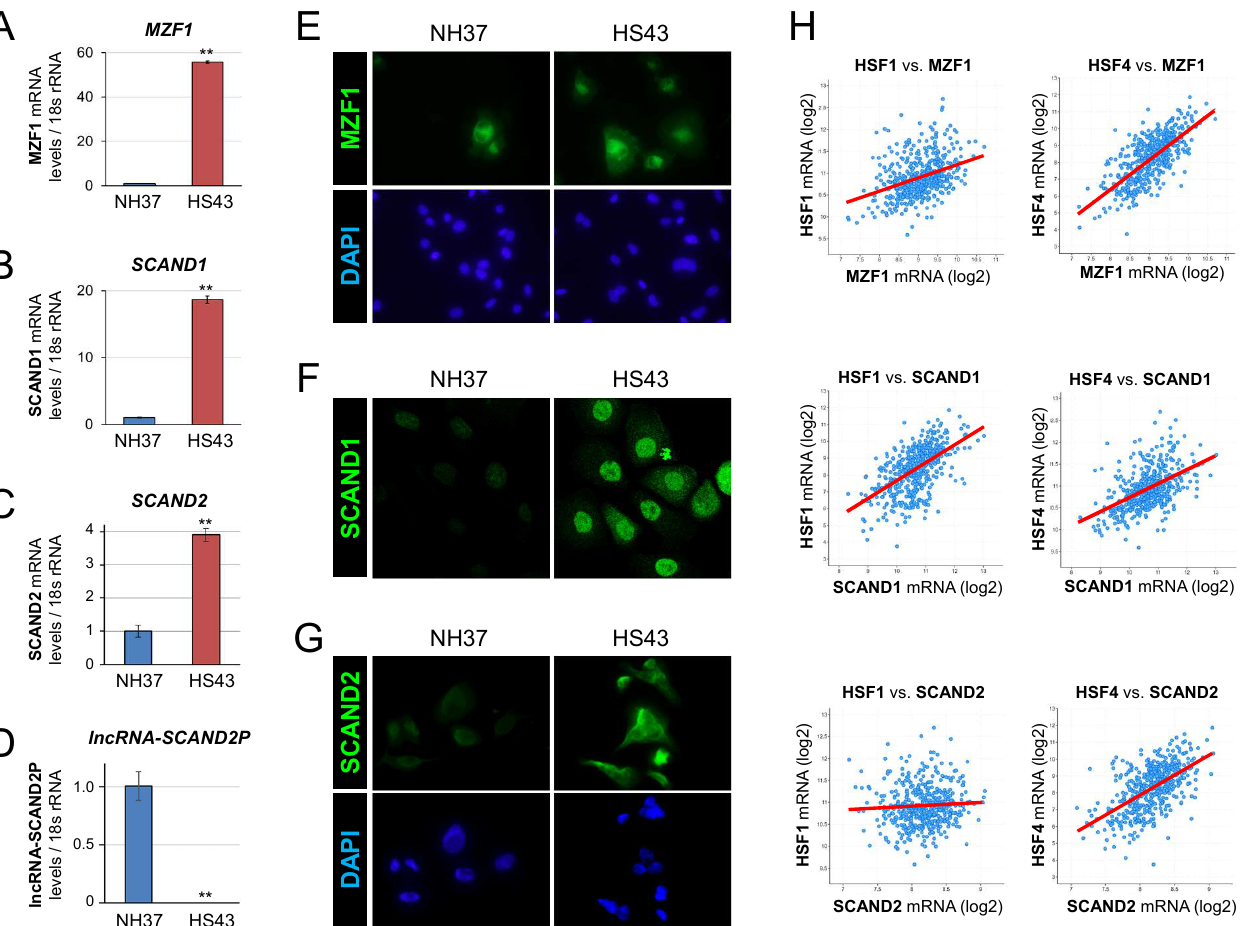
Figure 3. Heat shock stress induces the expression of MZF1(ZSCAN6), SCAND1, and SCAND2 but eliminates lncRNA-SCAND2P in DU-145 prostate cancer cells. ( A – D ) qRT-PCR analysis for MZF1 ( A ), SCAND1 ( B ), and SCAND2 ( C ) RNA and lncRNA-SCAND2P ( D ) upon HSS. LncRNA-SCAND2P was detected under the NH37 condition but lost after HSS. NH37, non-heated at 37 ◦ C. HS43, heat- shocked at 43 ◦ C for 30 min. ** p < 0.01, n = 3. ( E – G ) immunocytochemistry of MZF1 ( E ), SCAND1 ( F ), and SCAND2 ( G ) expressed with or without heat shock. ( H ) Co-expression correlation between HSF1 or HSF4 vs. MZF1 , SCAND1 , and SCAND2 in patient-derived prostate adenocarcinoma (494 samples, TCGA PanCancer